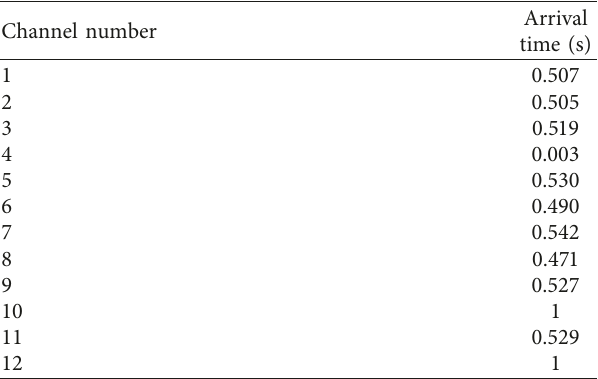
Figure 10: Waveforms and picked first arrival times acquired by the MS system with 12 sensors (vertical lines show the first arrival times). Table 2: First arrival time of every station (sensor).